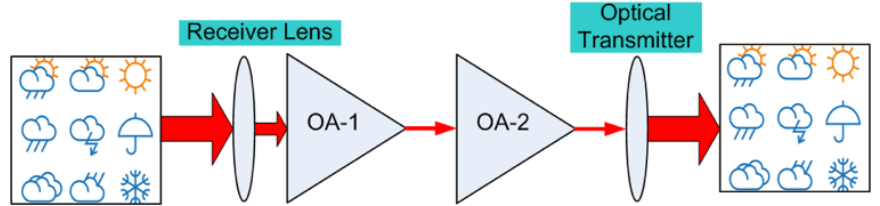
Figure 16. The configuration of a node composed of optical amplifiers, OA-1 and OA 2, in the AR and AF schemes.